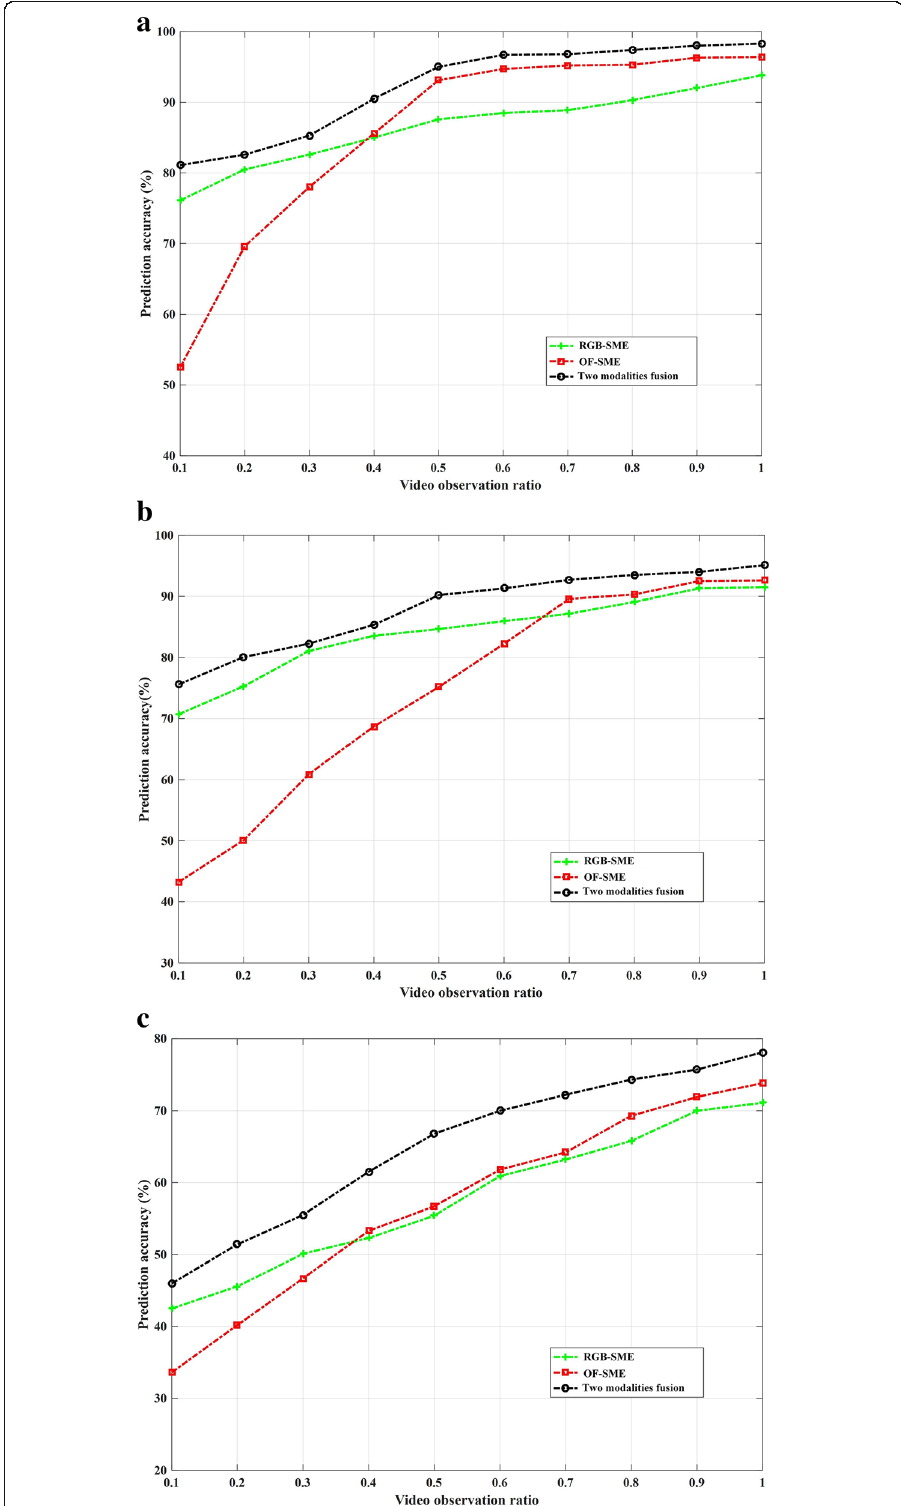
Fig. 7 Accuracy comparison of different modalities for three datasets. a UT-Interaction set 1. b UT-Interaction set 2. c